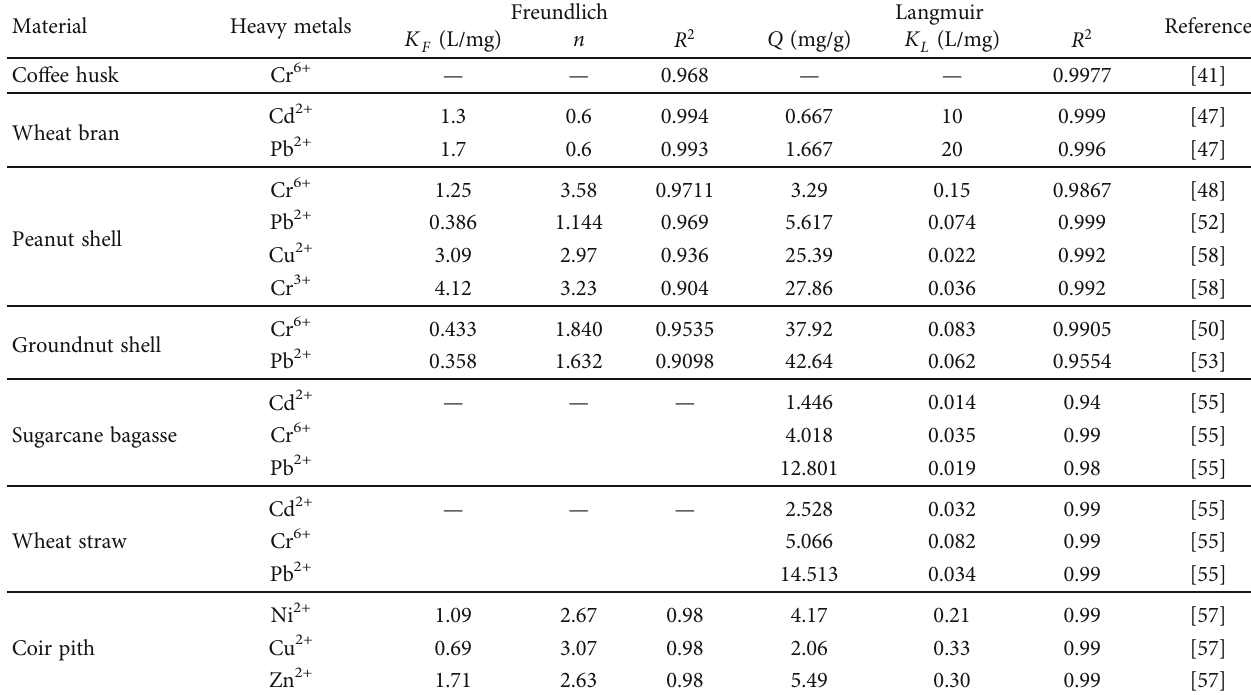
Table 8: Reported parameter values for Freundlich and Langmuir isotherm models for heavy metal adsorption on various biomass-derived